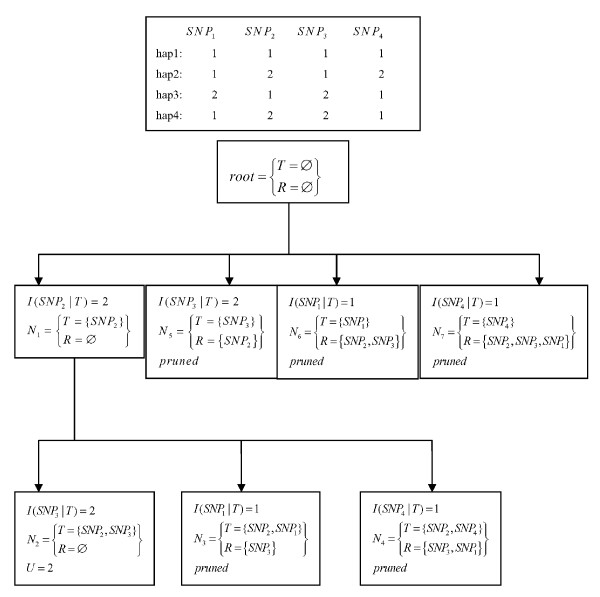
An example for generialized branch-and-bounnd algorithm with 4 SNPs and 4 haplotypes. The htSNPs performance criterion is to distinguish all the different haplotypes. The depth-first searching starts from root, exploring nodes in the order N1, N2,..., N7. N2 is the globally optimal solution. N3,..., N7 are all pruned from further consideration.